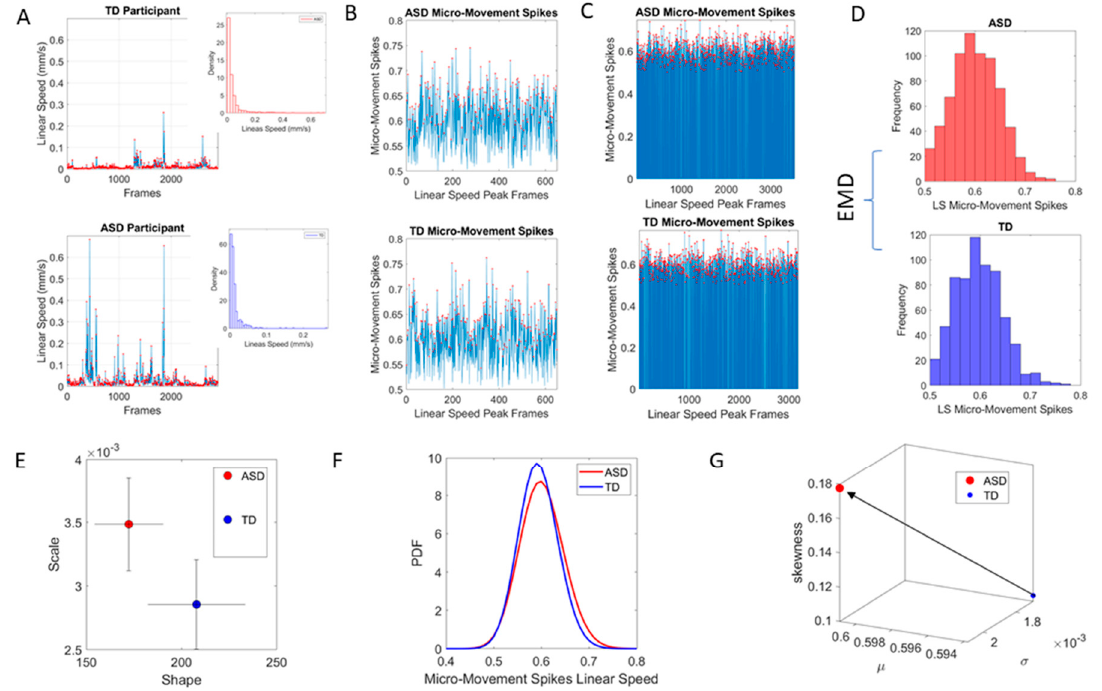
Figure 2. Methods: ( A ) Raw data in the form of linear speed (mm/s) extracted from images of ABIDE using traditional methods to clean the motor artifacts generated by involuntary motions of the head, as the participant attempts to remain still upon instruction during resting state fMRI. Peaks denoting fluctuations in amplitude are highlighted in red dots. Insets show histograms of the raw peaks. ( B ) The micro-movement spikes (MMS see methods explanation) are extracted from the moment by moment fluctuations in peak amplitude (see methods for normalization). They are unitless spike trains and the normalized peaks are gathered in frequency histograms (see insets in A) ( C ) Full micro-movement spikes from all original frames are used to ascertain statistical differences using the same number of frames in the original raw data. ( D ) The frequency histograms of the peaks are compared using the earth mover’s distance (EMD see methods explanation) quantifying the cost to transform one histogram into the other. ( E ) Comparison of stochastic signatures on the Gamma parameter plane spanned by the shape of the empirically estimated distribution and the scale (noise to signal ratio) indicating the dispersion of the PDFs in ( F ). ( G ) Gamma moments are used to build a scatter of points on a parameter space where the first three moments (mean, variance and skewness) are represented as x, y, z axes and the fourth moment, the kurtosis is reflected in the size of the marker. A fifth dimension is used to represent the color of the marker using e.g., the range of EMD values determined in ( D ).